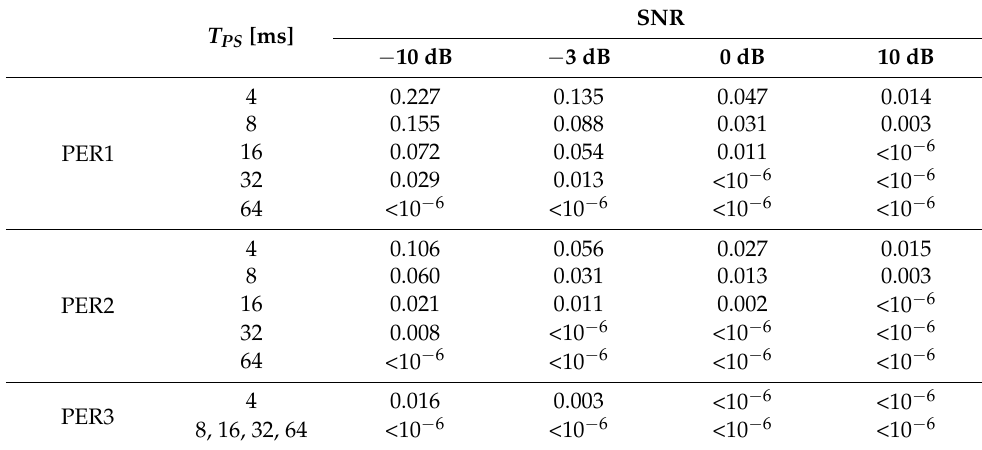
Table 5. Preamble Error Rate (PER) values for different values of T PS and SNR—channel NOF1 (Threshold